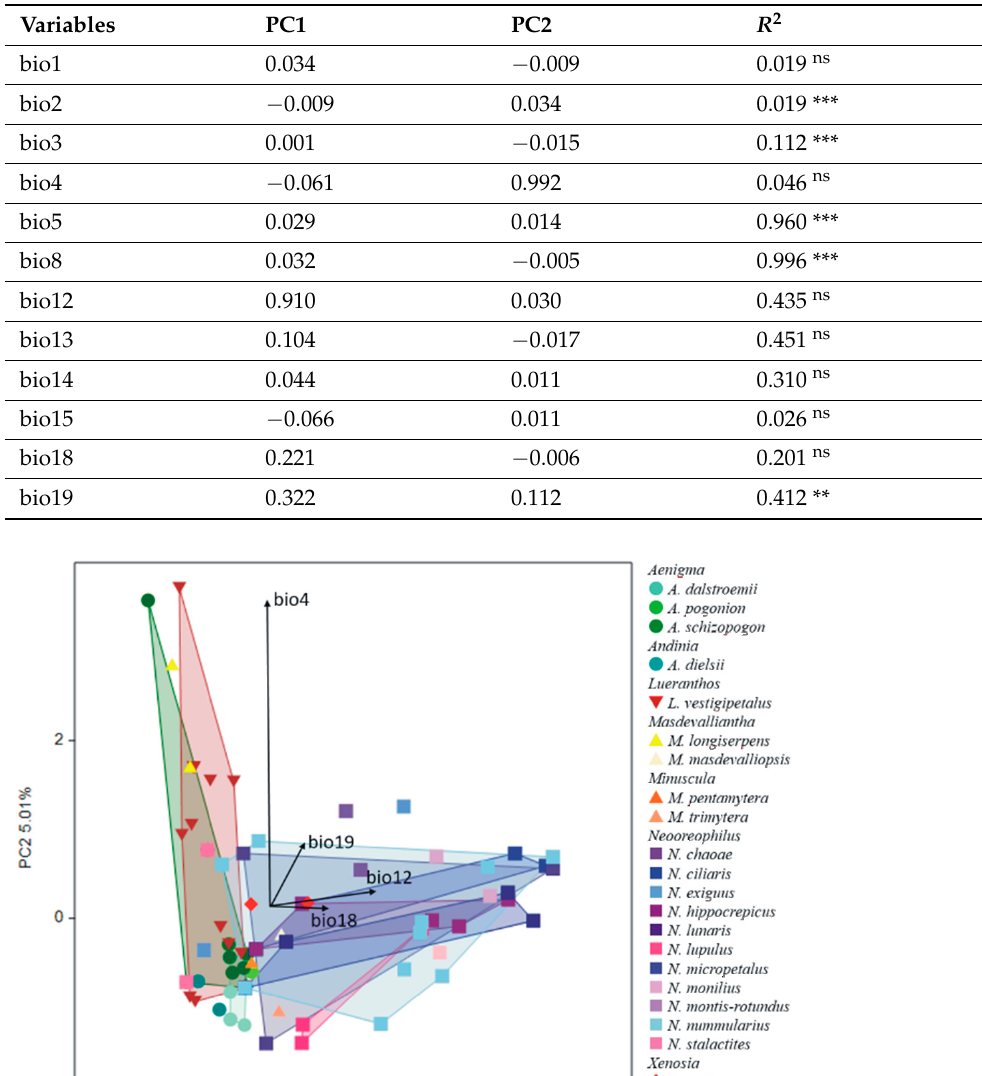
Table 2. Variables fitted to the PCA analysis focusing on climatic niche similarity of the studied species and determination coefficients ( R 2 ), where level of significance is marked (ns—not significant;